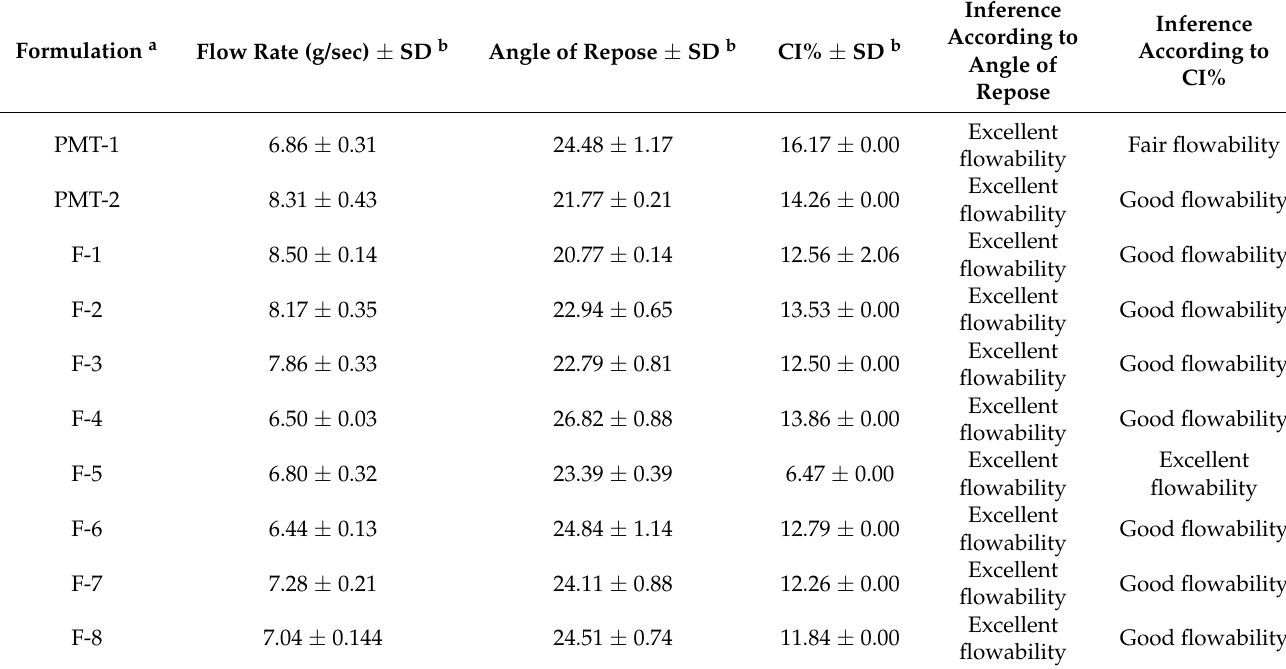
Table 3. Flow rate (g/sec), angle of repose and Carr’s compressible index (CI%) of all formulations ( n = 3).